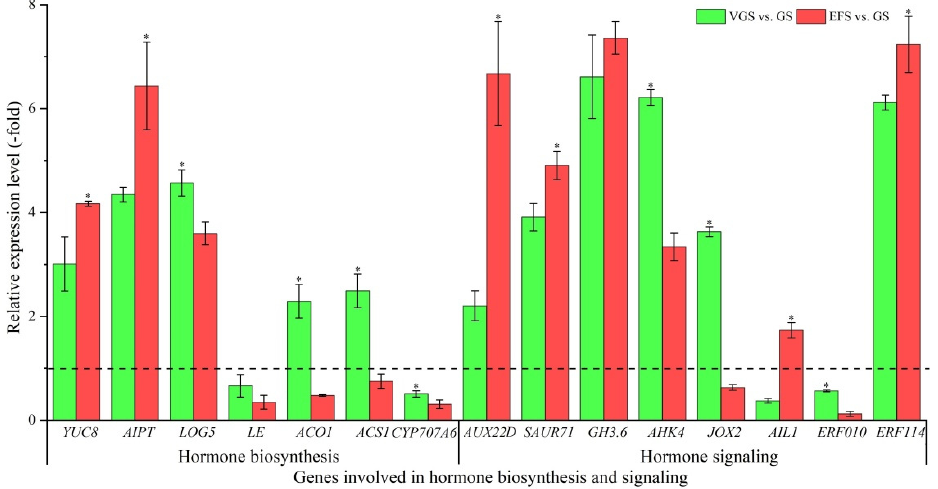
Figure 9. The relative expression level of genes involved in hormone biosynthesis and signaling at VGS and EFS vs. GS, as determined by qRT-PCR (mean ± SD, n = 3). The “*” represents a significant difference ( P < 0.05) at different growth stages for the same gene.